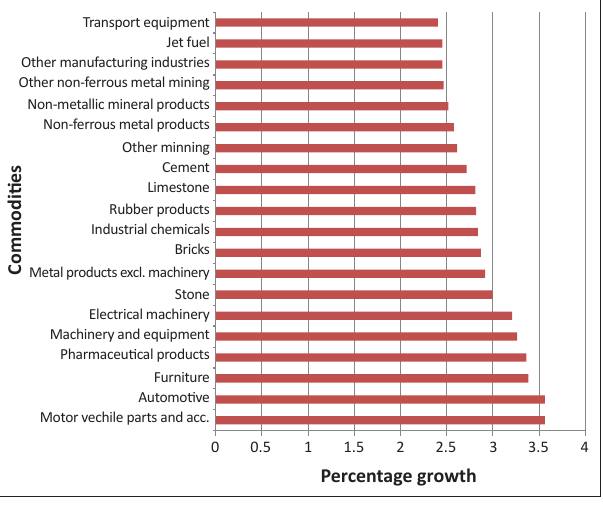
FIGURE 2: Top 20 commodities by percentage tonnage growth 2011–2041.